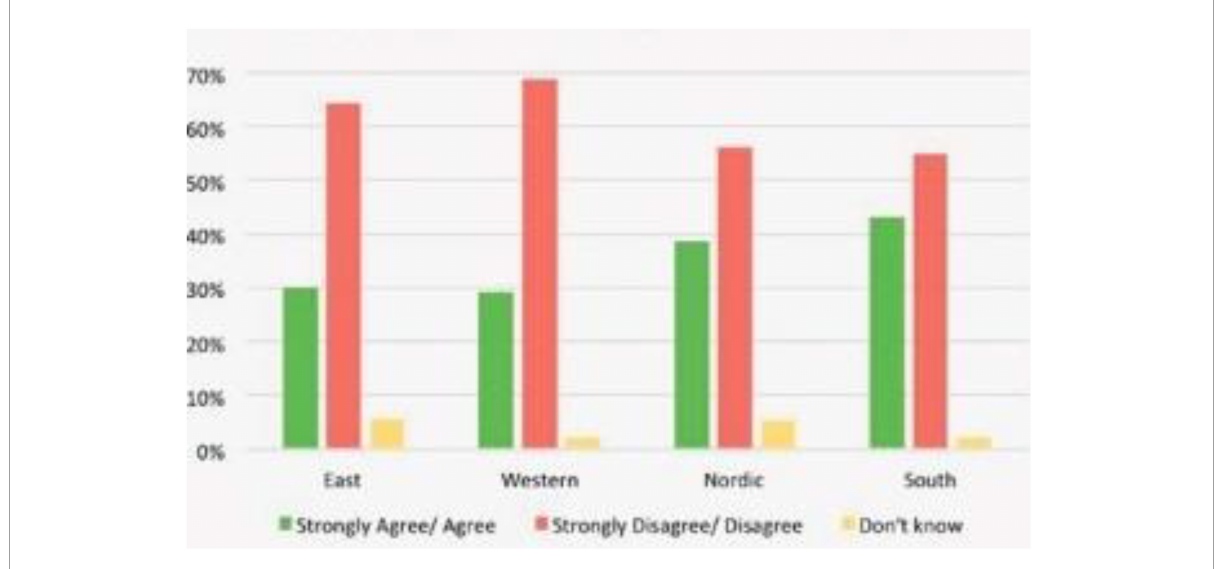
FIGURE2 Digitalization is fancy word for new